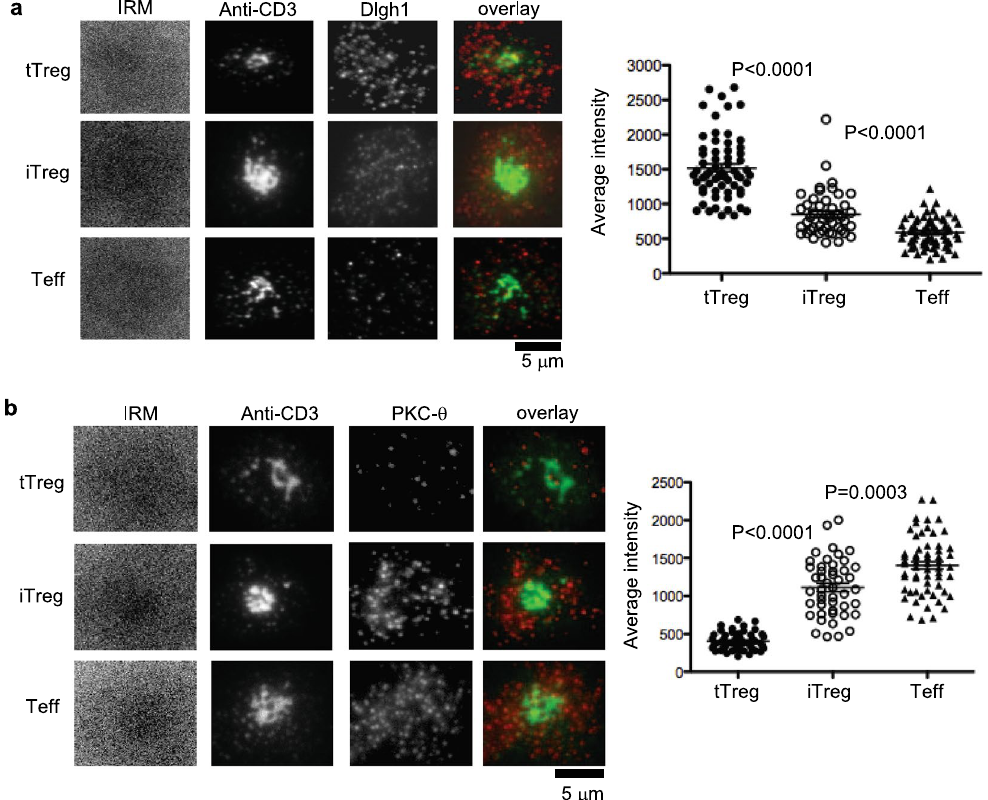
Figure 1. Dlgh1 and PKC- θ are recruited differently to IS in tTregs, iTregs and Teffs. MACS bead purified human CD4 + CD25 hi (tTreg), CD4 + CD25 − T cells activated by TGF- β and Rapamycin (iTregs) and CD4 + CD25 − T cells (Teffs) were introduced into bilayers containing both anti-CD3 (5 µ g/ml) and ICAM-1 at 250 molecules/mm 2 fixed at 20 min and permeabilized, stained with anti-Dlgh1 ( a ) and anti-PKC- θ ( b ) antibodies and imaged by TIRFM. The panels show representative images. Dlgh1 and PKC- θ staining was quantified by calculation of average fluorescence intensity in cells. Data are representative of two different experiments. P values were calculated using Mann-Whitney